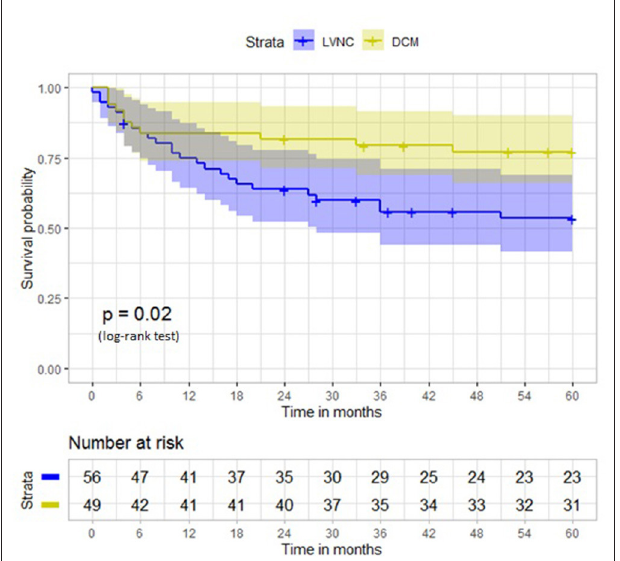
FIGURE 4 | Survival free from primary outcome at 5-year follow-up in patients with LVNC depending on their left ventricular ejection fraction. LVNC, left ventricular non-compaction; LVEF, left ventricular ejection